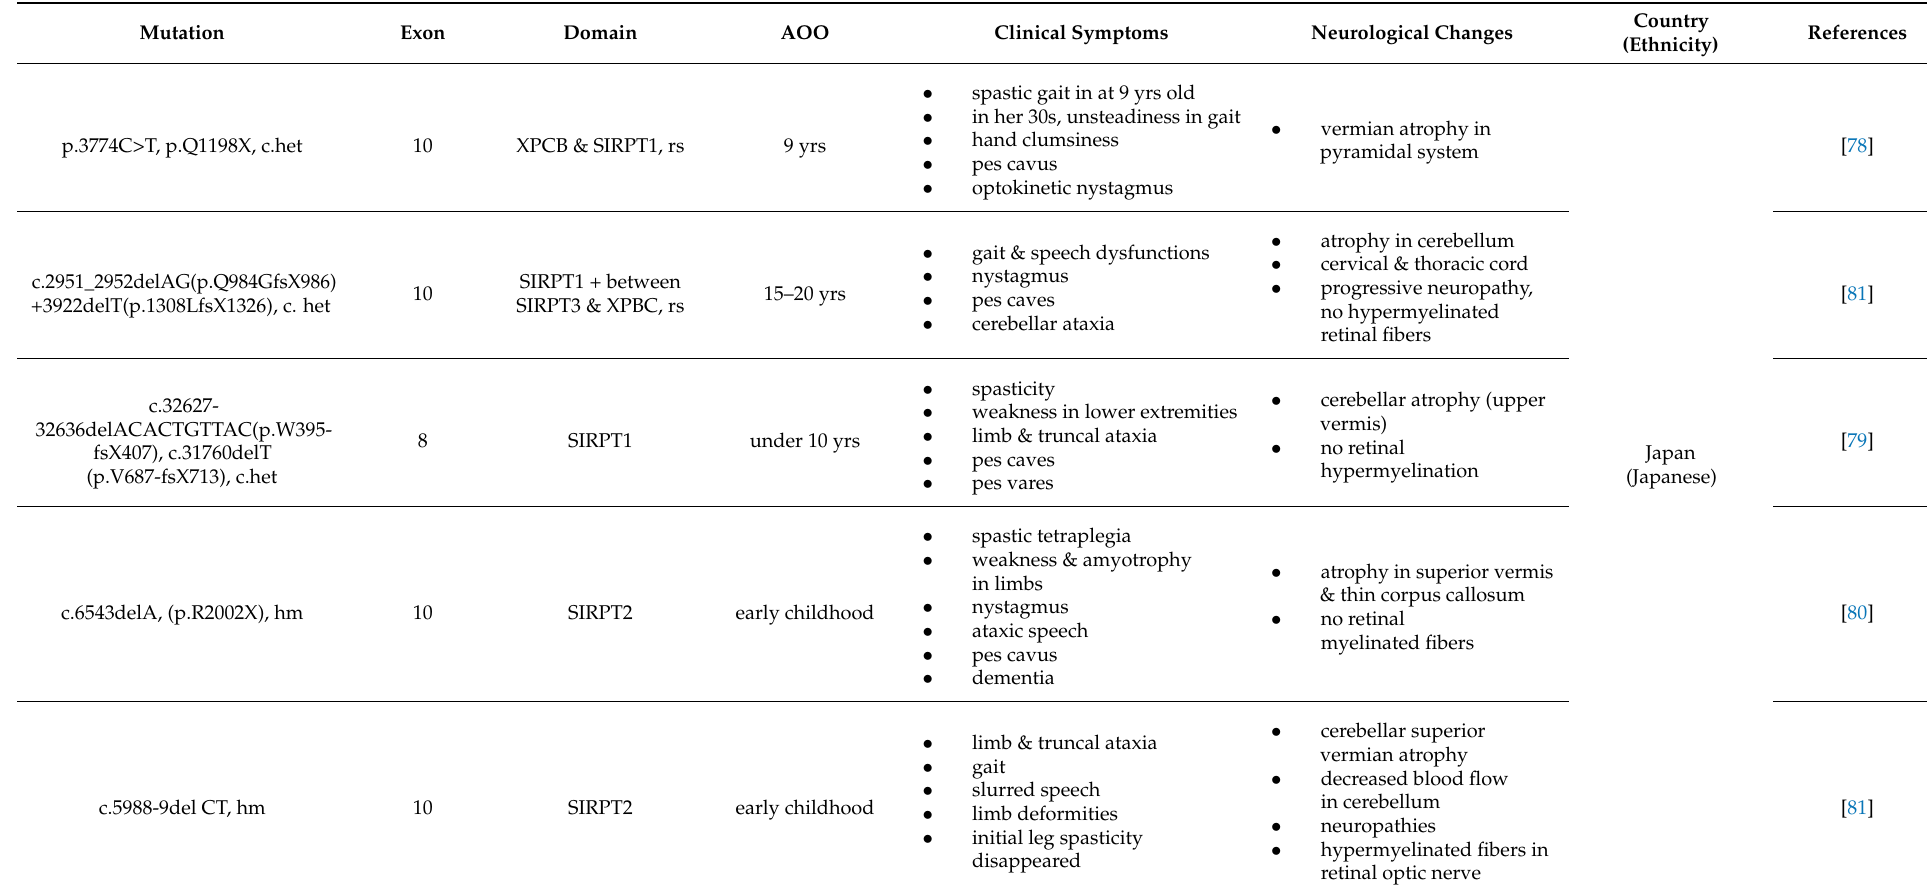
Table 3. SACS mutations discovered in Asia. “hm” means mutation carried the homozygous form, “c het” means mutation had compound heterozygous allele. “rs” means